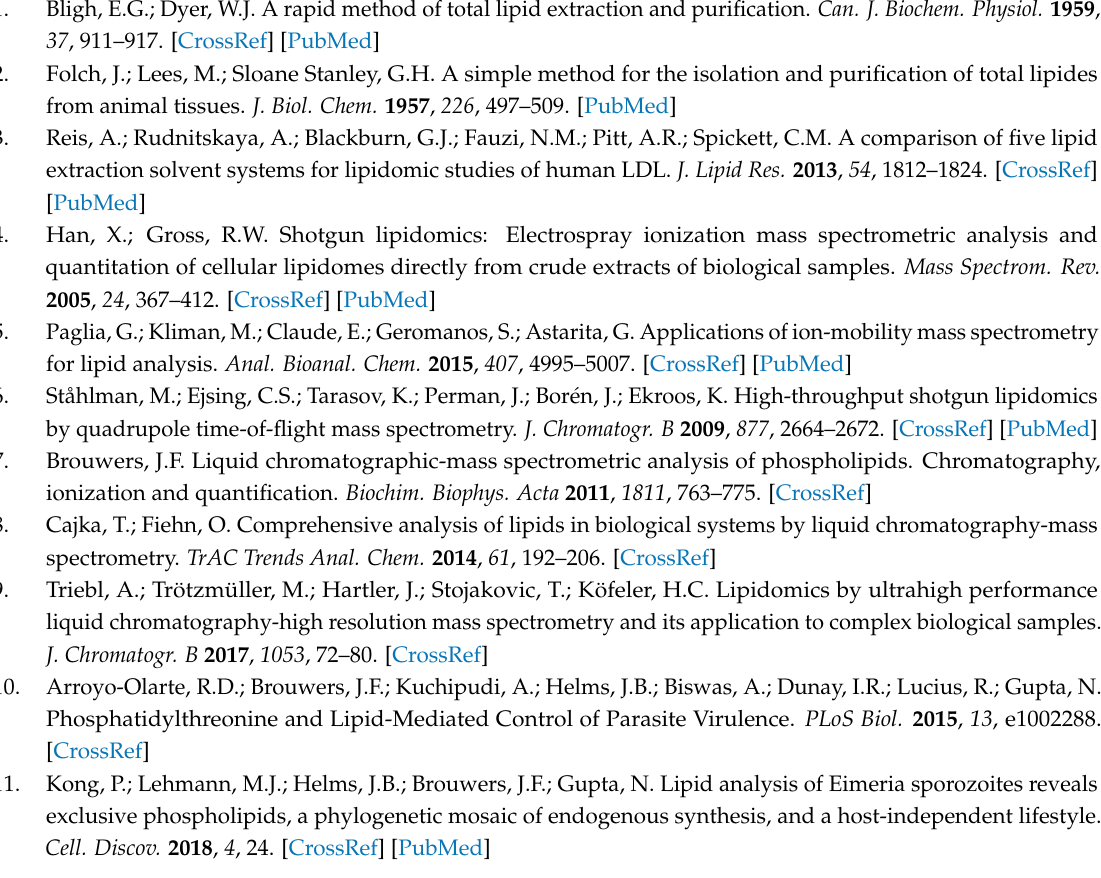
Supplementary Materials: Supplementary table 1A: Top 100 of LCMS signal contributions of unique lipid species. APCI generated ions were detected in a linear ion trap and annotated by their mass to charge ratio and retention time. In the case of co-eluting species with identical n. Supplementary table 1B : p -Values compared to CTRL. Values are not corrected for multiple comparison. Supplementary table 2: Lipid species detected in HeLa cells by negative mode electrospray ionization on a high-field orbitrap MS following hydrophilic interaction liquid chromatography. Lipids are annotated by their experimentally determined mass to charge ratio and retention time. Note that PC, HexCer and SM species are detected as their formate adducts. An 'A' in the lipid name indicates an ether species. Sphingosine (d18:1) was assumed as the sphingoid base, only when no match was found, sphinganine (d18:0) was assumed. Supplementary methods: MS acquisition